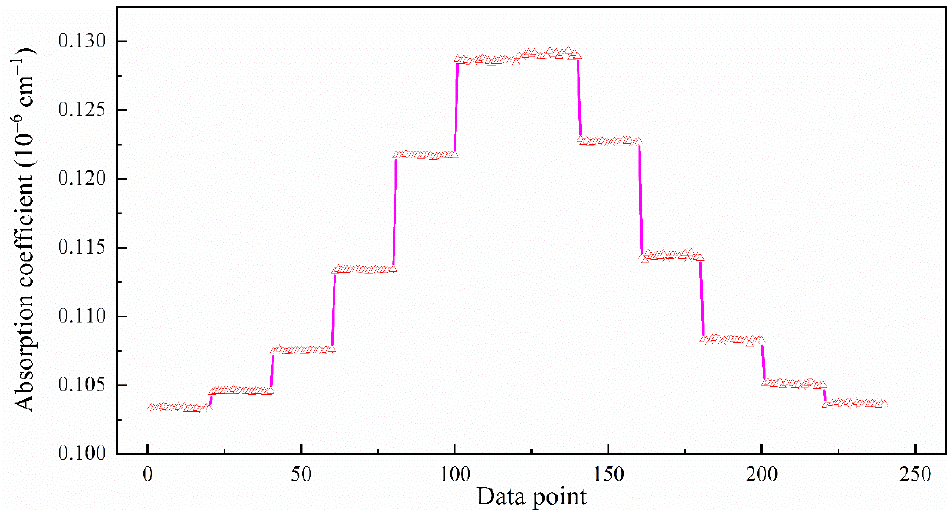
Figure 4. Recording of a step-scanned spectrum across an absorption line of 13 CH 4 at 1658.689 nm. At each laser frequency set to a consecutive cavity resonance frequency, 20 ringdown events were measured.